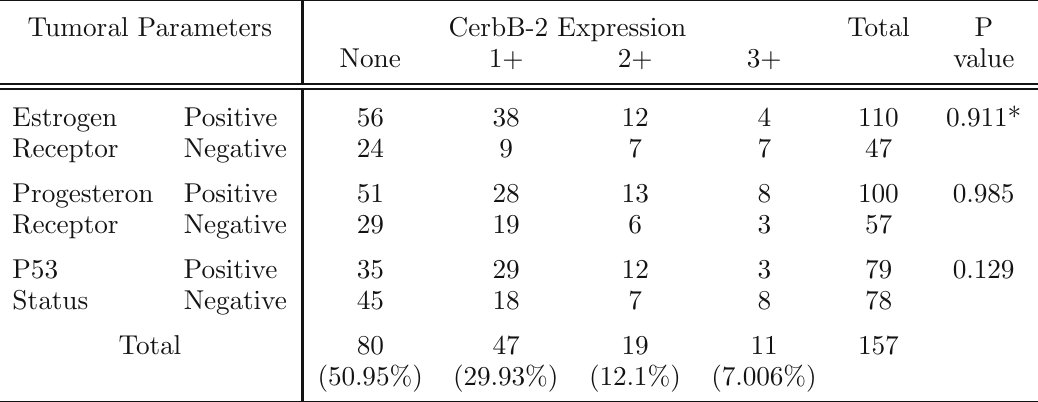
Table 4 Distribution of patients due to tumoral